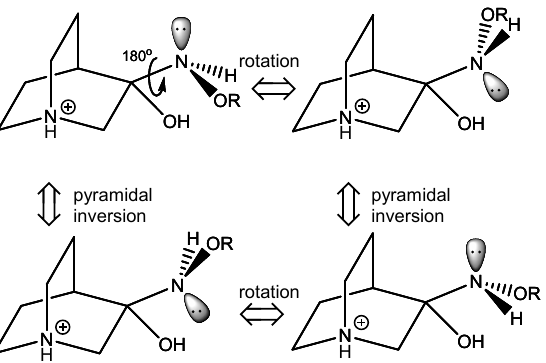
Figure 6. Polytopal rearrangement of RI conformers relevant to the formation of products.